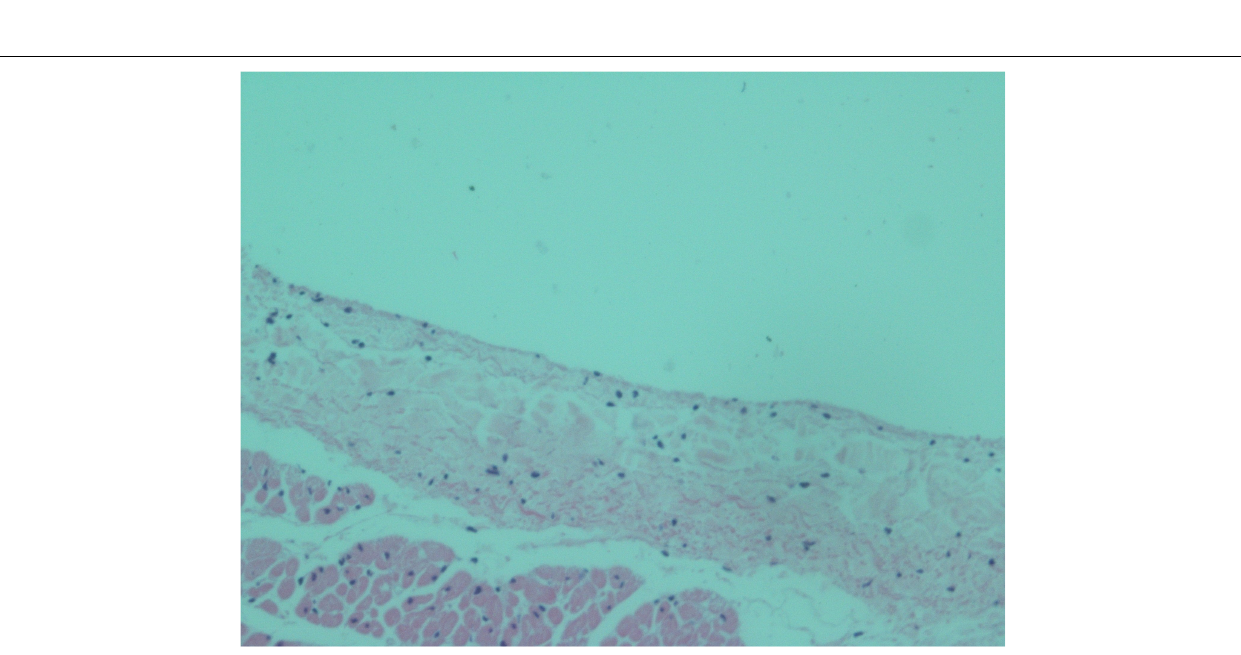
Frontiers in Physiology |